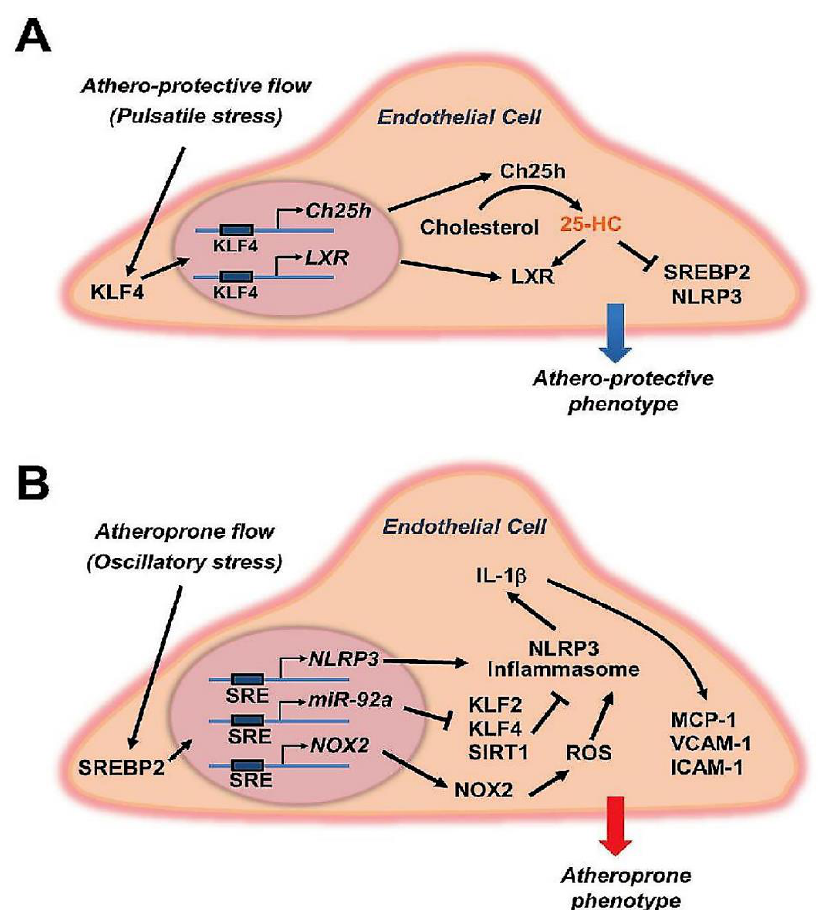
Figure 3. Fluid dynamics regulate the function of endothelial cell through ( A ) an atheroprotective effect favoured by the pulsatile flow inducing a higher expression of Kruppel-like factor 4 (KLF4) or alternatively ( B ) an atheroprone effect related to the oscillatory flow that causes an increased level of sterol regulatory element-binding proteins (SREBP). Different biochemical and molecular mechanisms regulate the two different conditions. Atheroprotective flow is characterised by substantial greater production of KLF4 that leads to the expression of Ch25h and LXR with increased intracellular levels. This mechanism promotes higher production of 25-HC, SREBP2 and NLRP3. Atheroprone phenotype as consequence of an atheroprone flow (oscillatory stress) led to increased level of SREBP2 due to greater expression of SRE and its encoding molecules. This nuclear activation favours a detrimental effect by increased intracellular level of KLF2, KLF4, SIRT1 (gene miR-92a), NOX2 (gene NOX2) and NLRP3 inflammasome (gene NLRP3). The results are higher level of IL-1 β leading to a major production of MCP-1, VCAM-1 and ICAM-1. Abbreviations: 25-HC = 25-hydroxycholesterol, CH25H = Cholesterol 25-Hydroxylase, KLF = Kruppel-like factor, ICAM-1 = Inter Cellular Adhesion Molecule-1, IL = interleukine, (MCP-1/CCL2) = Monocyte chemoattractant protein-1, NLRP3, NOD-like receptor family, pyrin domain containing 3, SREBP2 = sterol regulatory element-binding protein-2, SIRT1 = Sirtuin 1, VCAM-1 = vascular cell adhesion molecule 1.